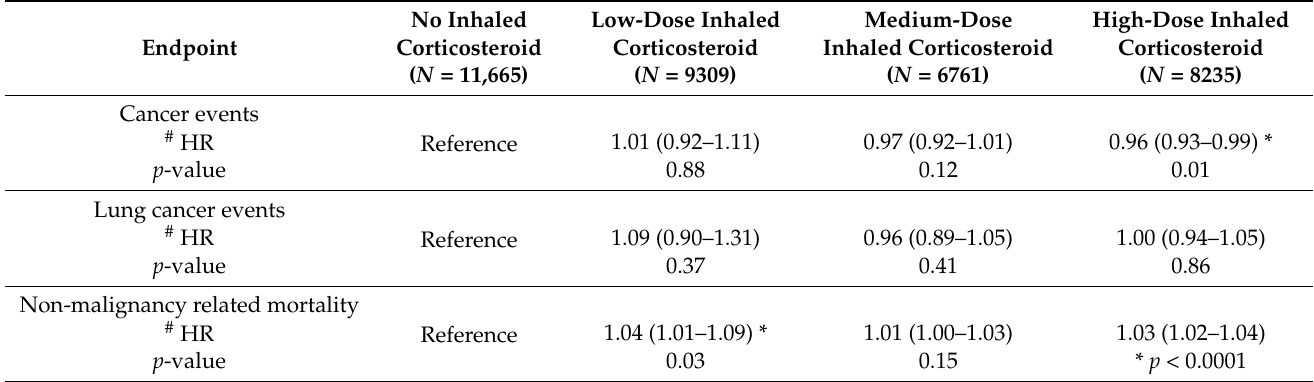
Table 4. Cancer events of patients with COPD without asthma and without previous malignancy within 5 years prior to